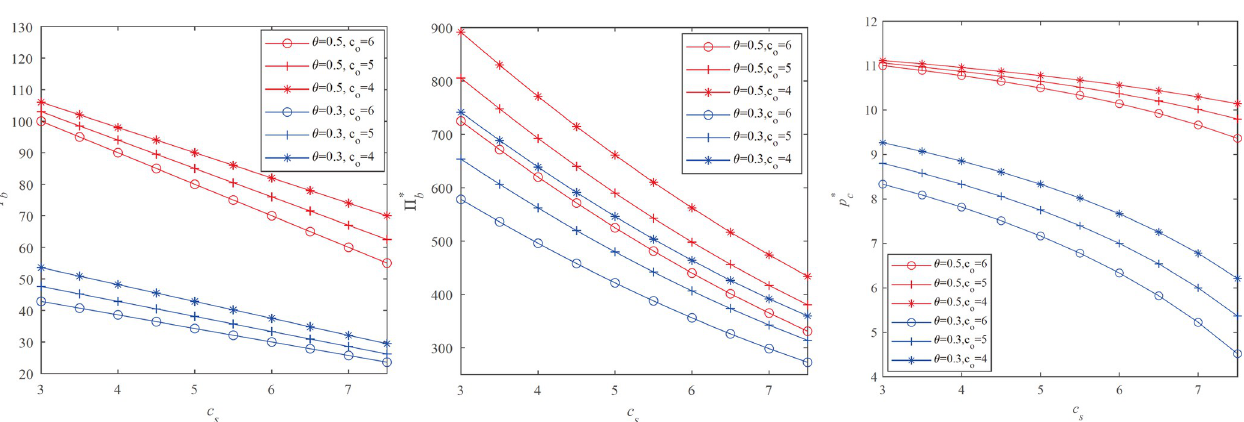
Fig 5. Impact of the unit fullfillment costs of the B&M store c s on the retailer’s optimal decision.